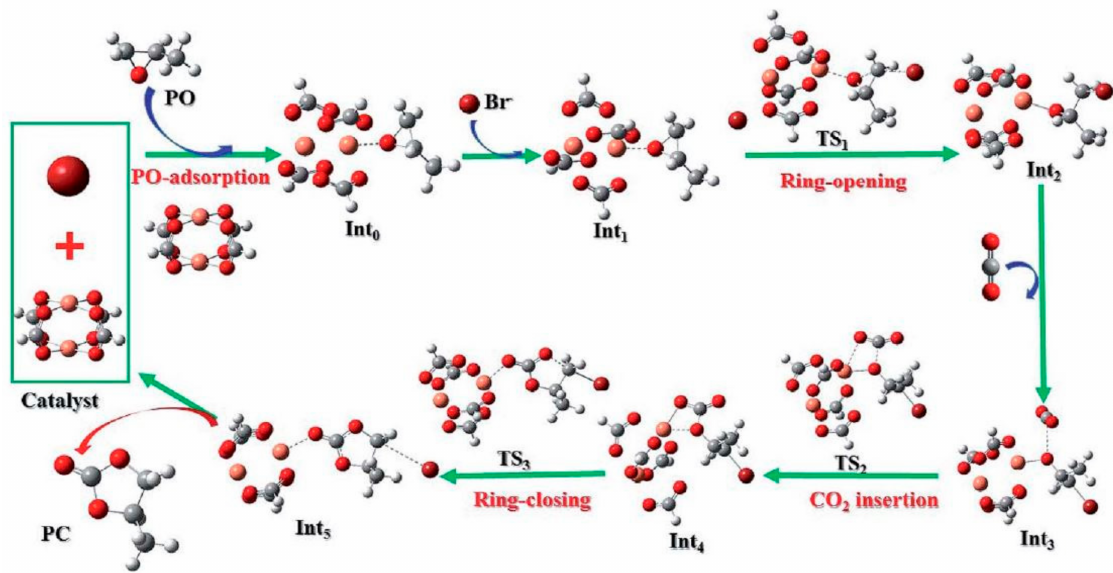
Figure 29. The mechanism study for the reaction of CO 2 with PO to obtained cyclic carbonates catalyzed by M-HKUST-1. Reprinted with permission from Ref. [133]. Copyright 2019 Royal Society of Chemistry.